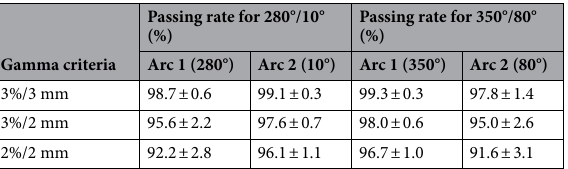
Table 5. Passing rates of each arc in 280°/10° and 350°/80° plans using 3%/3, 3%/2, and 2%/2 mm gamma criteria.